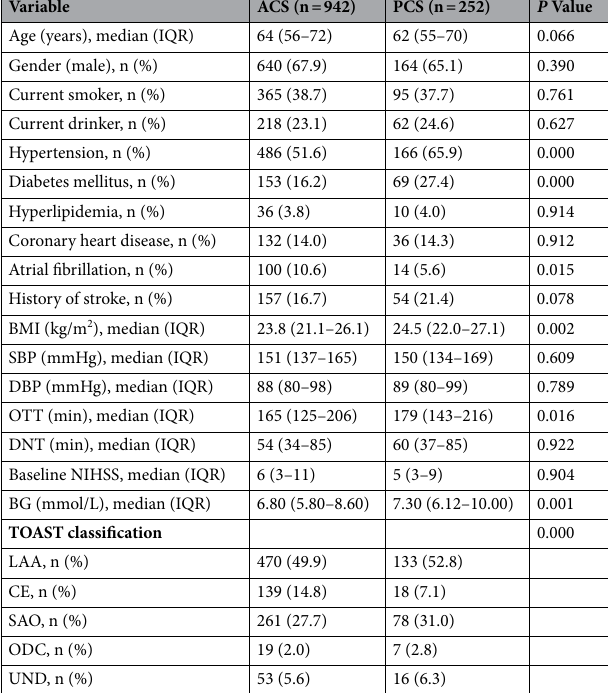
Table 1. Baseline characteristics in ACS group and PCS group. ACS anterior circulation stroke, BG blood glucose, BMI body mass index, CE cardioembolism, DBP diastolic blood pressure, DNT door to needle time, IQR interquartile range, LAA large-artery atherosclerosis, NIHSS National Institute of Health Stroke Scale, ODC stroke of other determined cause, OTT symptom onset to thrombolysis time, PCS posterior circulation stroke, SAO small-artery occlusion, SBP systolic blood pressure, TOAST trial of Org 10,172 in acute stroke treatment, UND stroke of undetermined